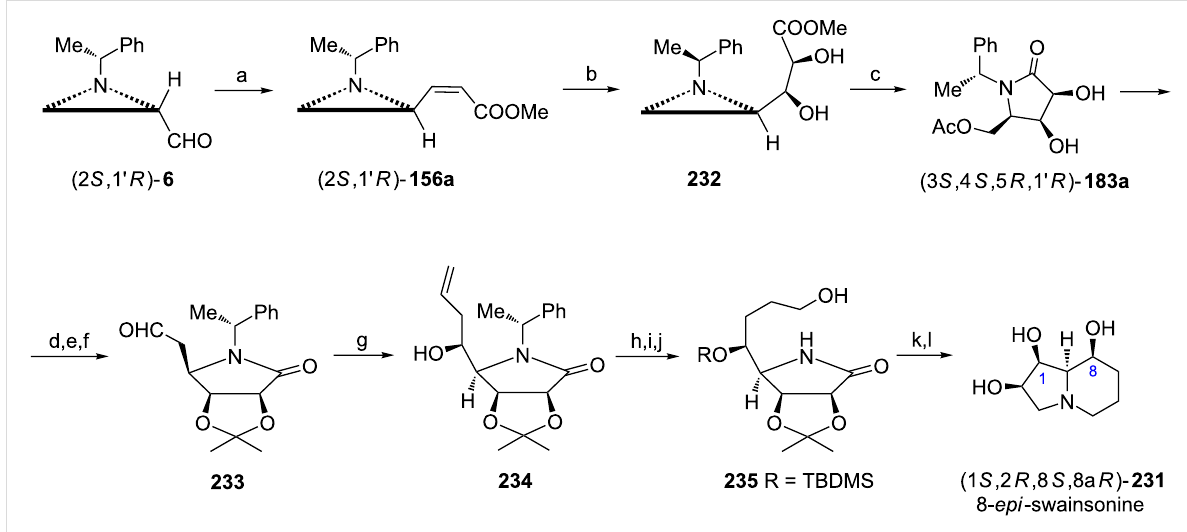
Scheme 58: Syntheses of 8- epi -swainsonine (1 S ,2 R ,8 S ,8a R )- 231 . Reagents and conditions: a) Ph 3 P=CHCOOMe, MeOH, 0 °C, 1 h; b) AD-mix- β ,